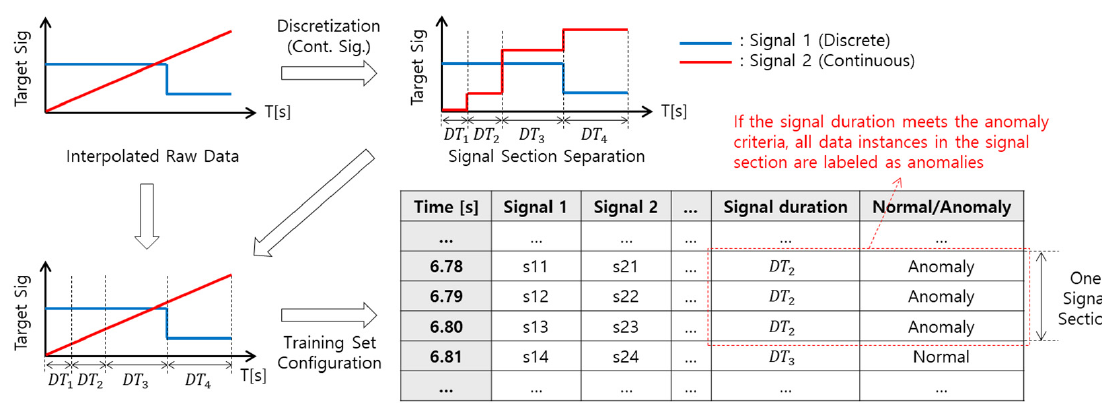
Figure 13. Derivation process of signal duration.